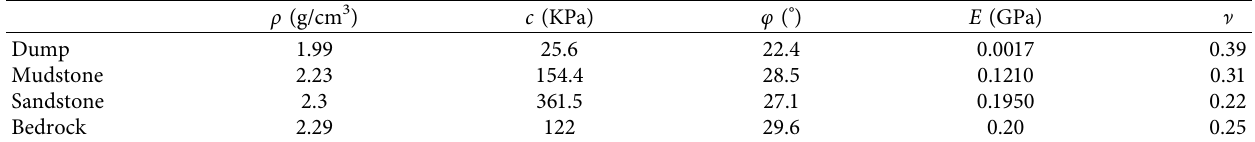
Figure 8: Elevation and slope of Lu Zigou anticline. Table 1: Parameters of rock mechanics.